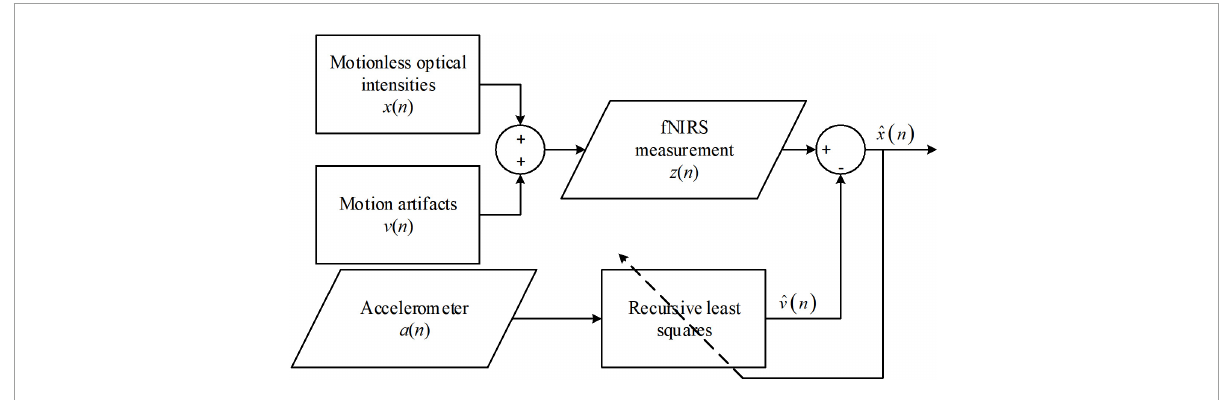
FIGURE2 Procedures of active noise cancellation (ANC) algorithm.